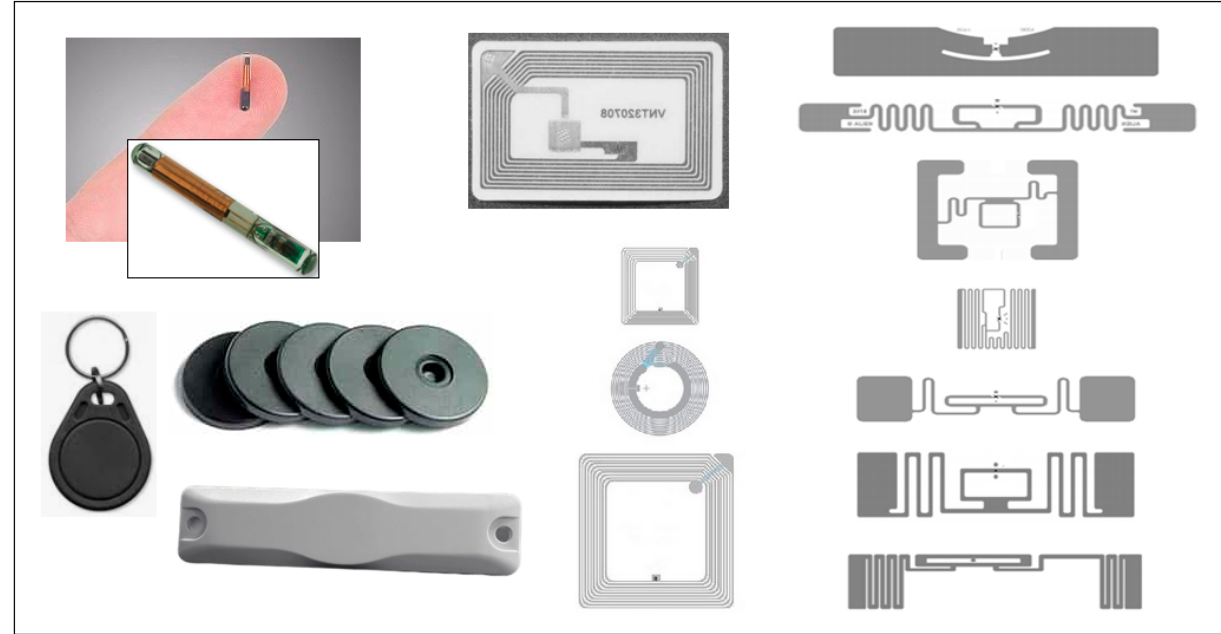
Figure 1. Examples of different types of tags.